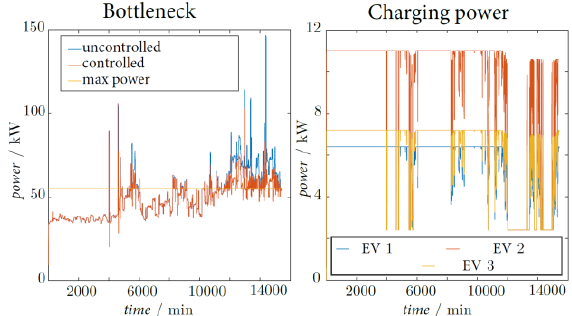
Fig. 11. Concept of grid supporting charging infrastructure